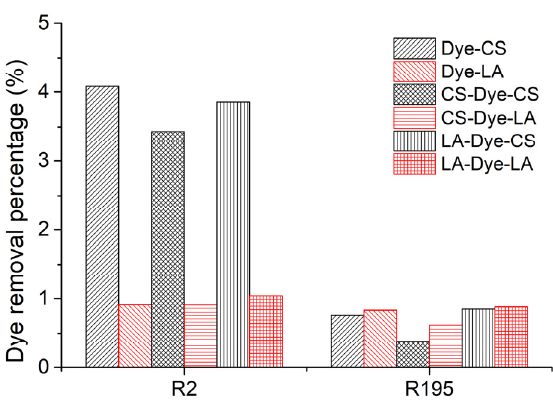
Figure 5. Effects of CS and LA post-mercerization on the dye stability of dyed woven cotton fabrics using R2 and R195 dyes.